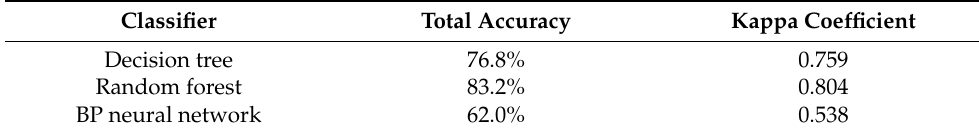
Table 3. Classification accuracy assessment of different classifiers.